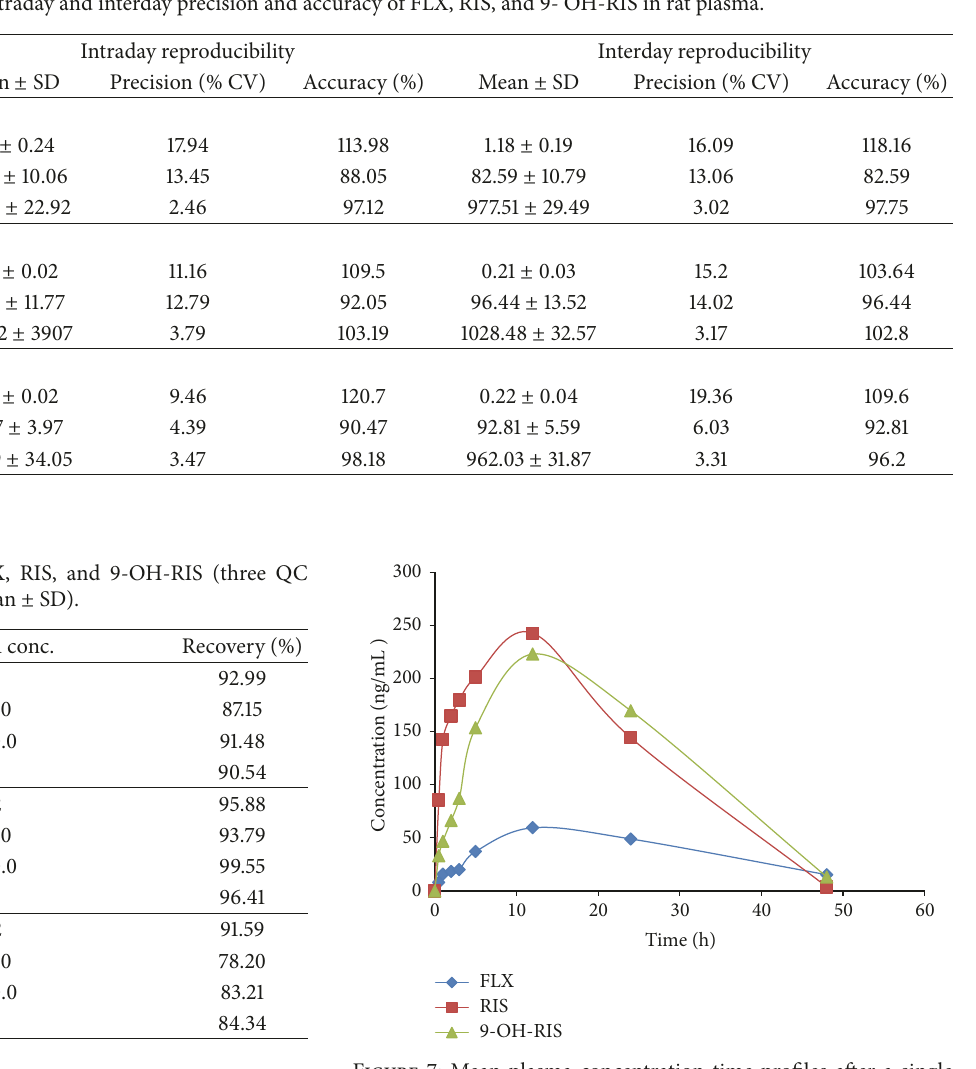
Figure 7: Mean plasma concentration-time profiles after a single oral dose of 10mg/kg of FLX and 0.3 mg/kg of